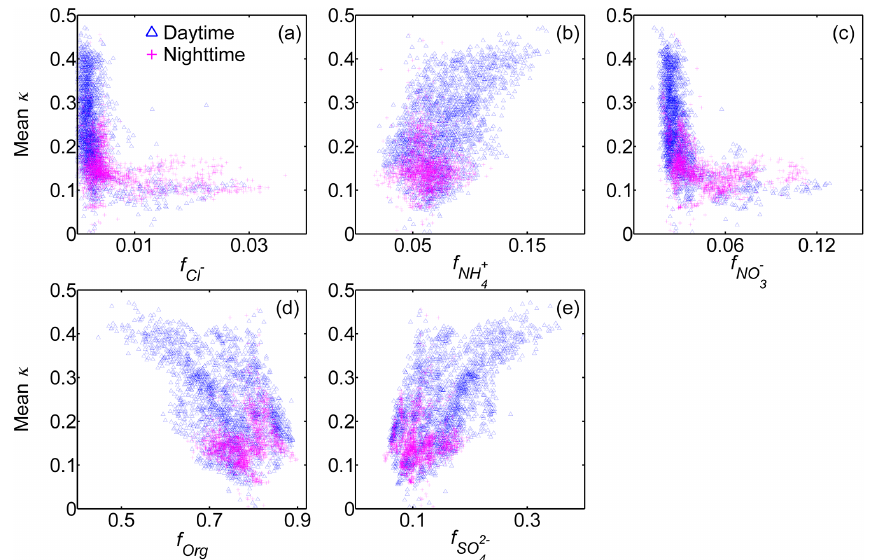
Figure 7. Relationships between the mean κ results (100nm) and the mass fractions of the five non-refractory chemical compositions of submicron wildfire haze